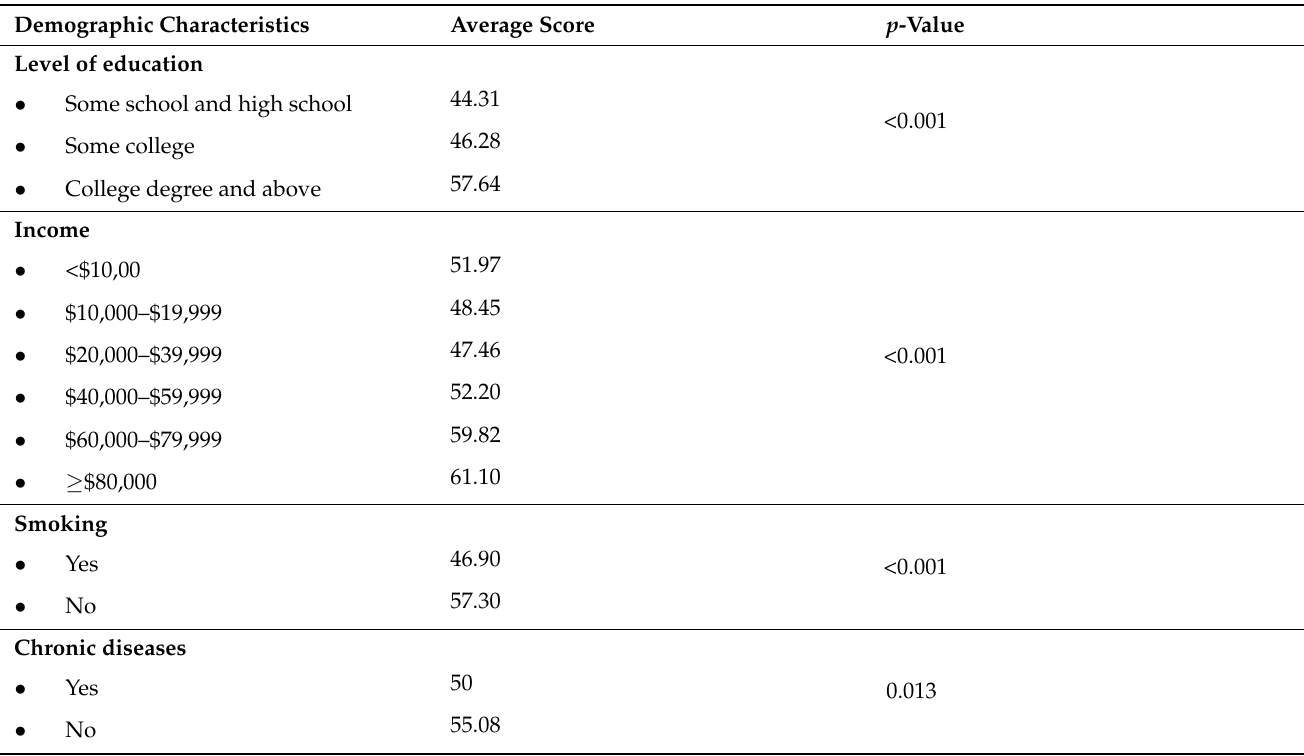
Table 4. The average RLT score stratified by different demographics with a total score of 100 (10 points per